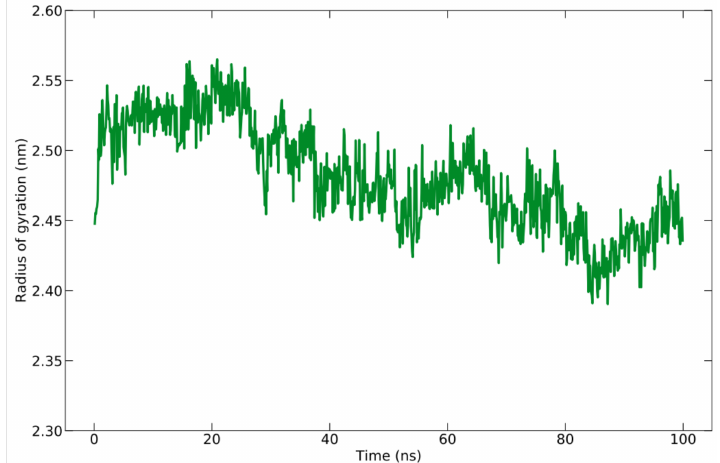
Figure 6. Rg graph during the simulation of 100